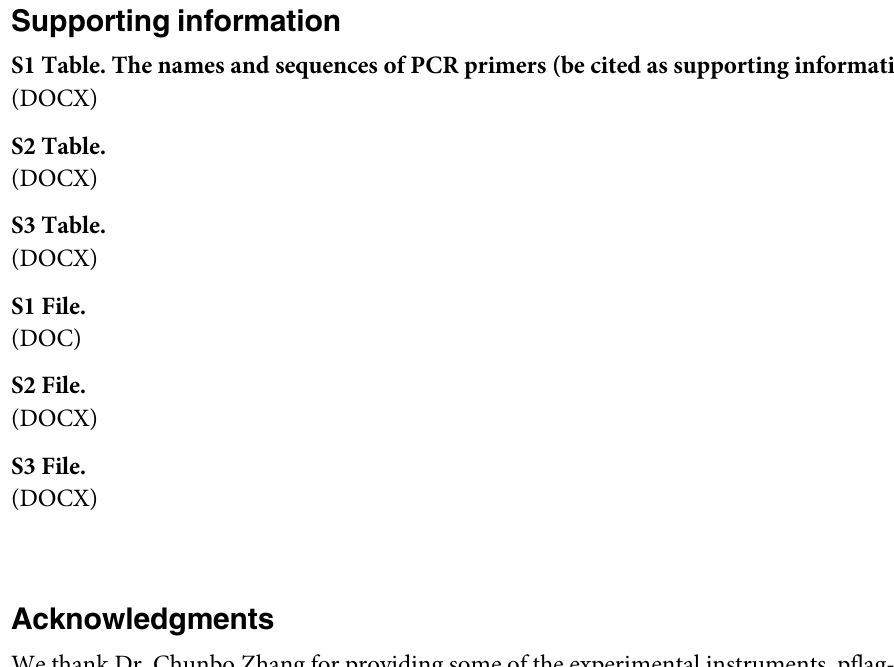
S1 Table. The names and sequences of PCR primers (be cited as supporting